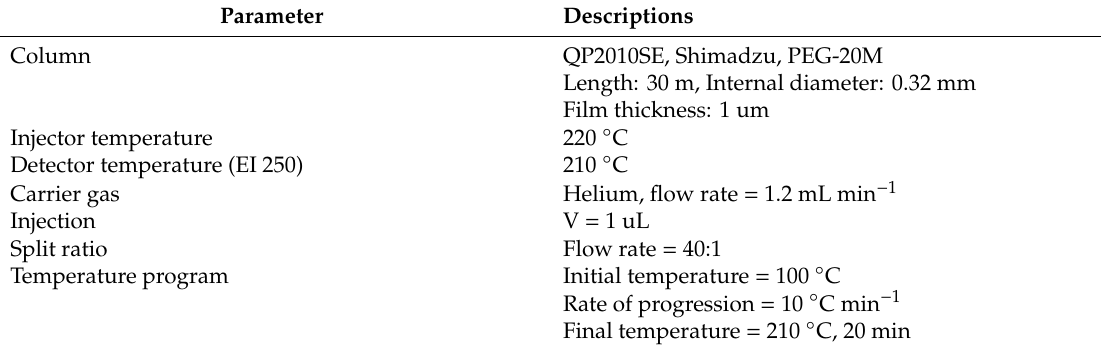
Table 1. Gas chromatograph